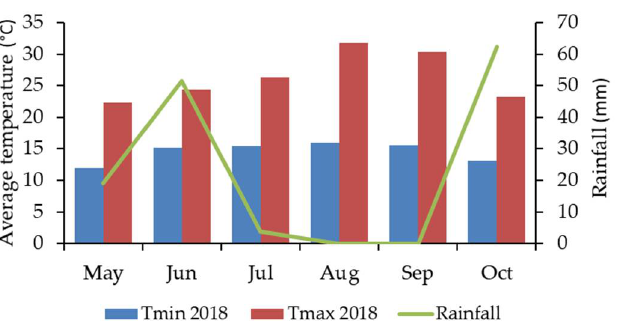
Figure 1. Weather station data focused on temperature (Tmin and Tmax) and rainfall in 2018, in Tagus Valley region, Portugal.